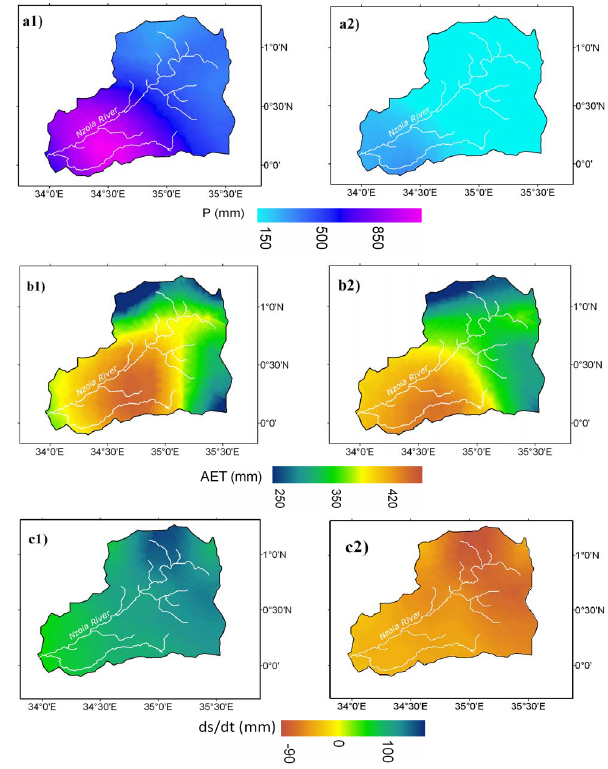
Fig. 8. Spatially distributed Precipitation ( P ) (a1, a2), Evapotran- spiration (ET) (b1, b2), Change in storage ( ds / dt ) (c1, c2) for wet season (from March to June) and dry season (from November to February) respectively averaged over study period